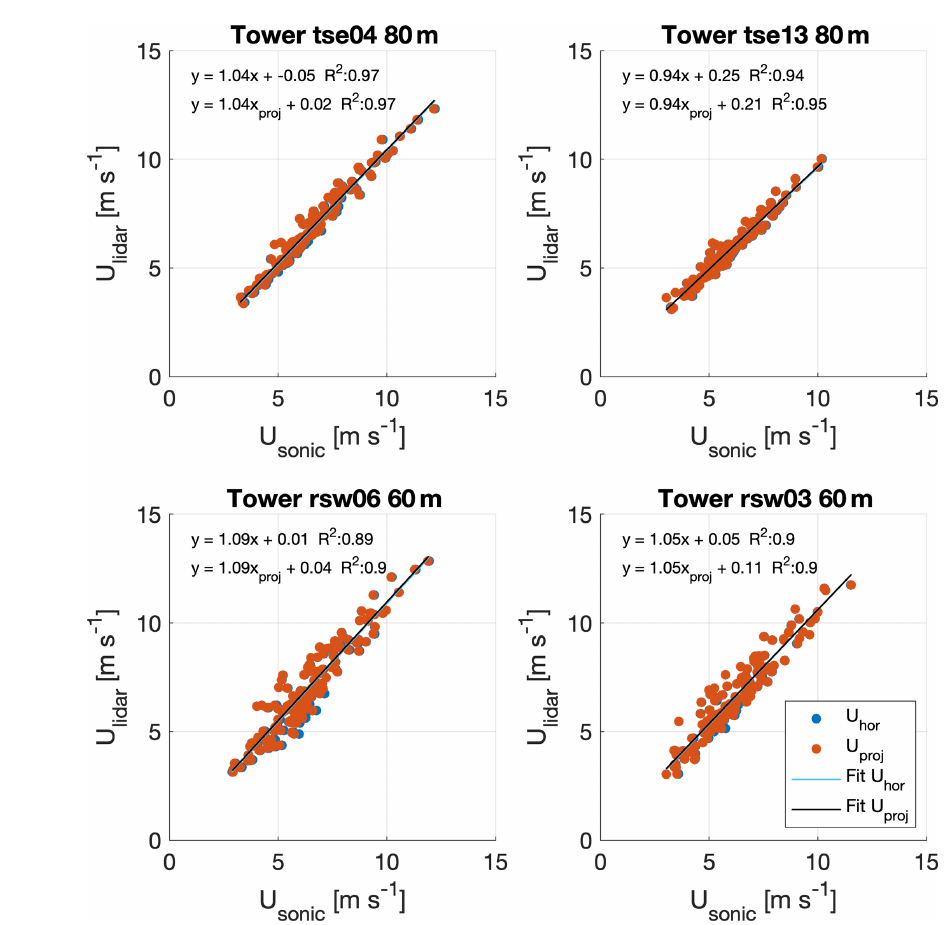
Figure 4. Correlation of reconstructed lidar wind speeds with the horizontal sonic wind speeds and the sonic wind speeds projected to the plane spanned by the lidars. Only southwesterly and northeasterly wind directions are selected for sectors of ± 15 ◦ , centered around the transect and oriented 54 ◦ towards north. Wind speeds at tse04, rsw06, and rsw03 are derived from the SLs 107 and 108 and at tse13 from the SLs 105 and